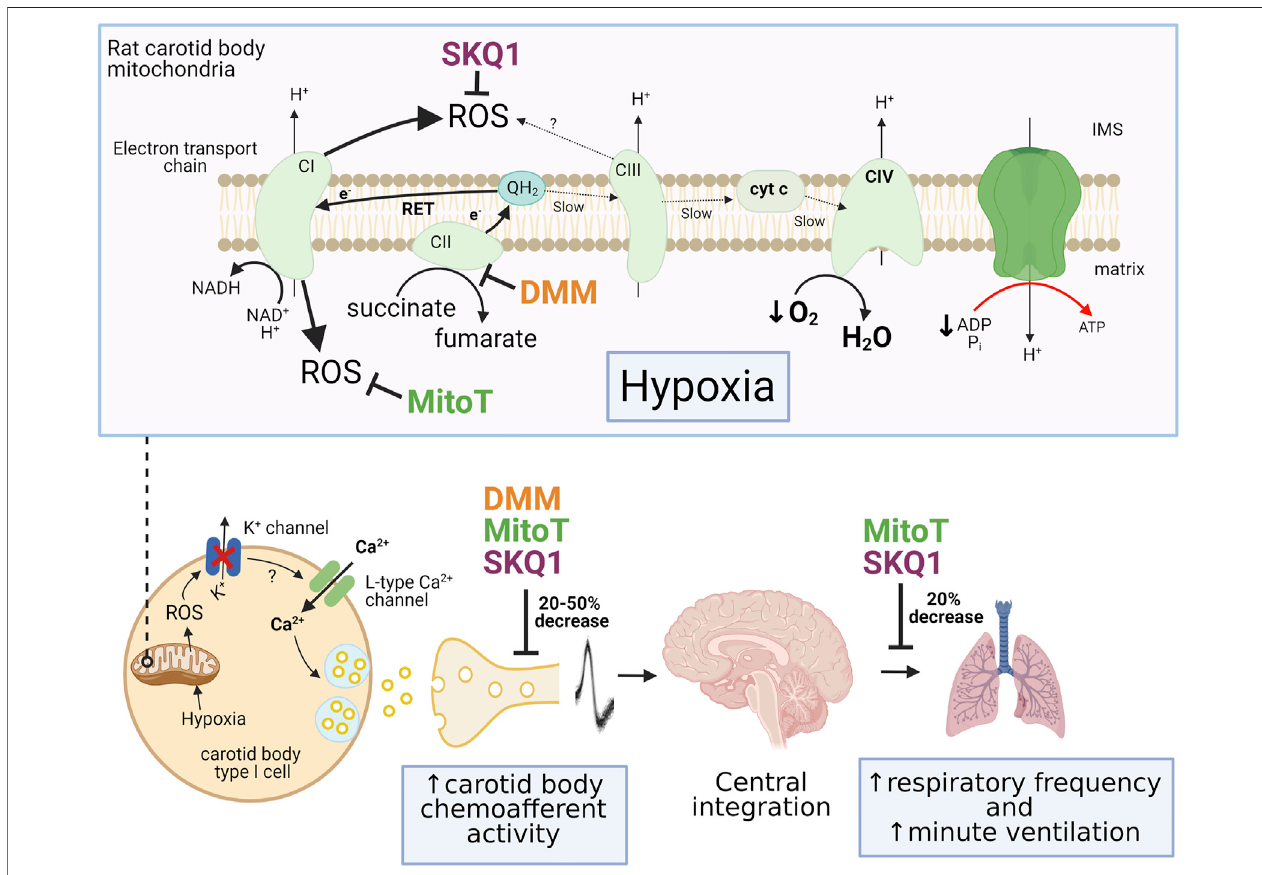
FIGURE2 | Summary ofthe effects ofpharmacological inhibition ofmitochondrial succinate metabolism and antioxidant treatment on carotid body and ventilatory responses to hypoxia. Top panel illustrates the mechanism of mitochondrial reactive oxygen species (ROS) generation through enhanced succinate metabolism at complex II (CII) and reverse electron transport (RET) during hypoxia. The sites of action of dimethyl malonate (DMM; complex II inhibitor), 10-(6 ′ -plastoquinonyl) decyltriphenylphosphonium (SKQ1) and MitoTEMPO (MitoT) are also shown. Lower panel shows the inhibitory effectof these pharmacological agents on the rises in carotid body chemoafferent discharge frequency, respiratory frequency and minute ventilation during hypoxia. IMS, intermembrane space; cyt c, cytochrome c. Adapted from (López-Barneo and Ortega-Sáenz, 2022), (Swiderska et al., 2021) and (Chouchani et al., 2014).